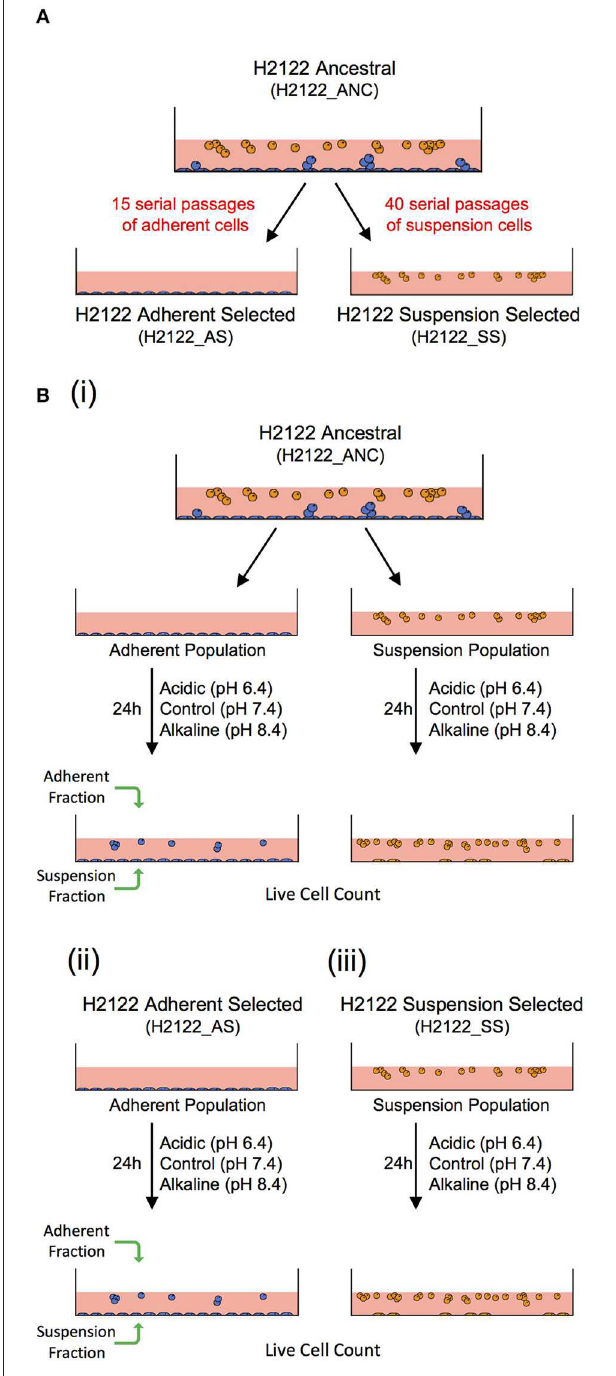
FIGURE 1 | An in vitro model-system to address the effect of the same microenvironmental change on genetically-related but phenotypically distinct cancer cell populations. (A) A non-small cell lung cancer line (H2122_ANC) was used to select for an adherent line (H2122_AS) and a suspension line (H2122_SS) through 15 and 40 serial passages of only the adherent or suspension populations, respectively. (B) Experimental design to address the effect of extracellular acidic and alkaline pH on the ANC_Adherent and ANC_Suspension populations of the (i) ANC line, and the (ii) Adherent Selected (AS) and (iii) Suspension Selected (SS)